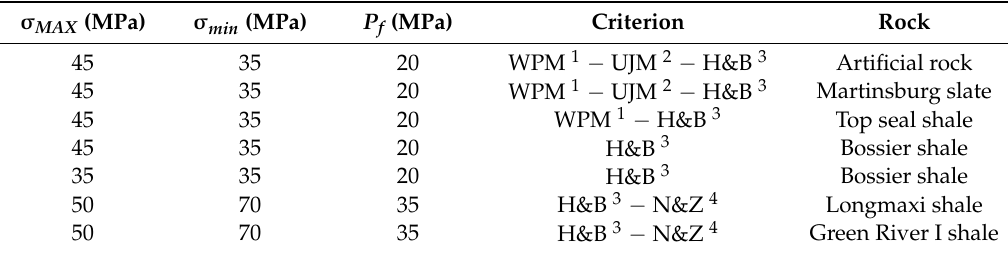
Table 3. Data and strength criteria used for the calculation of mud pressures for slip and fracturing. σ MAX